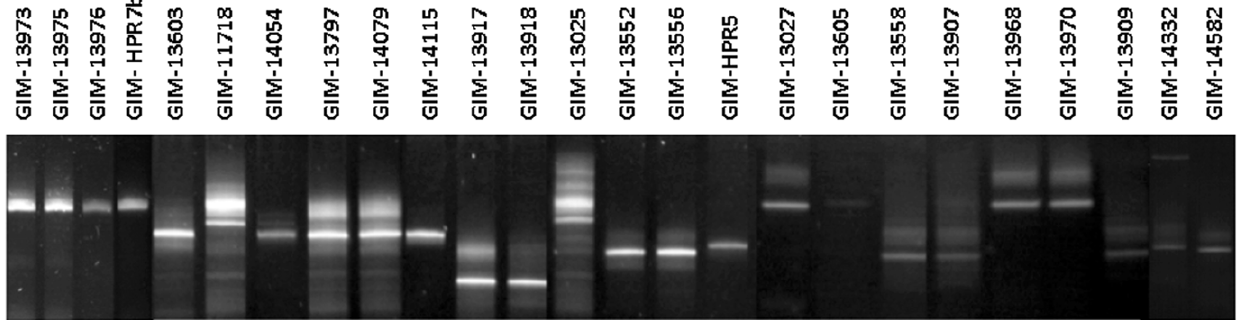
Figure 7. DGGE analysis of the 25 field samples showed in Table 2.